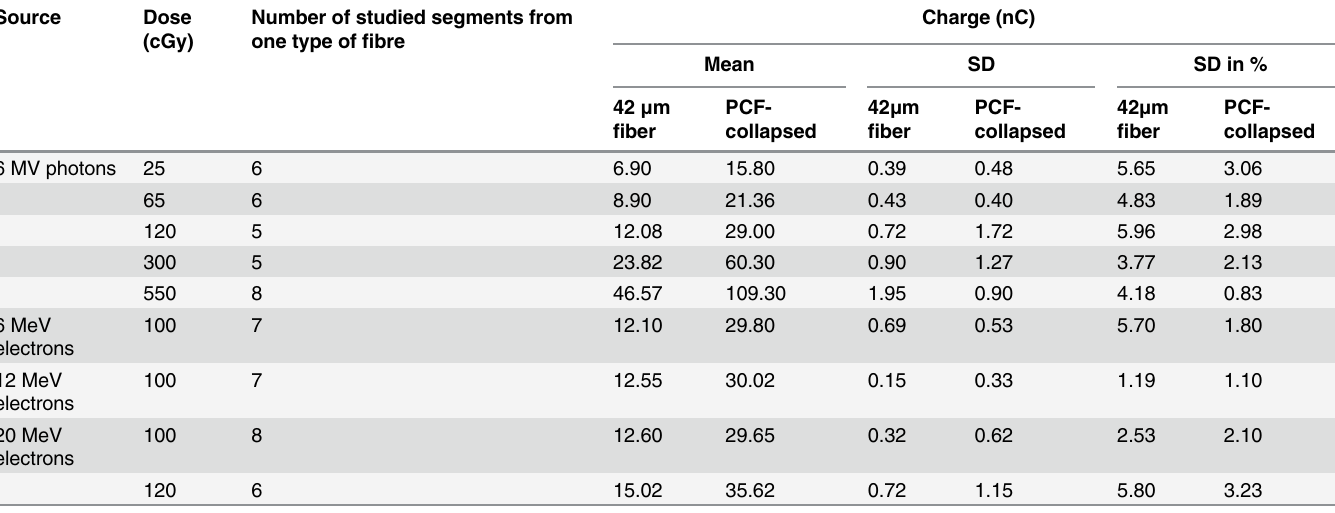
Table 2. Dose response reproducibility using electron and photon beams. Source Dose